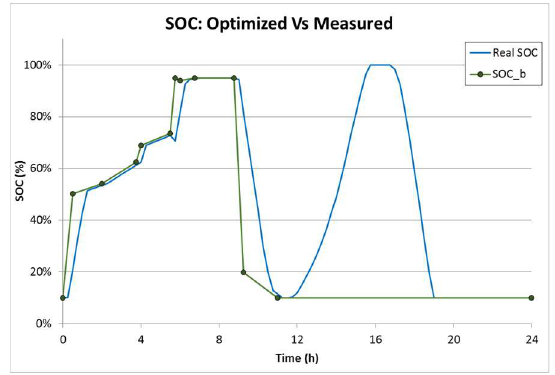
Figure 8. Optimized SOC b and actual SOC evolution through the day.